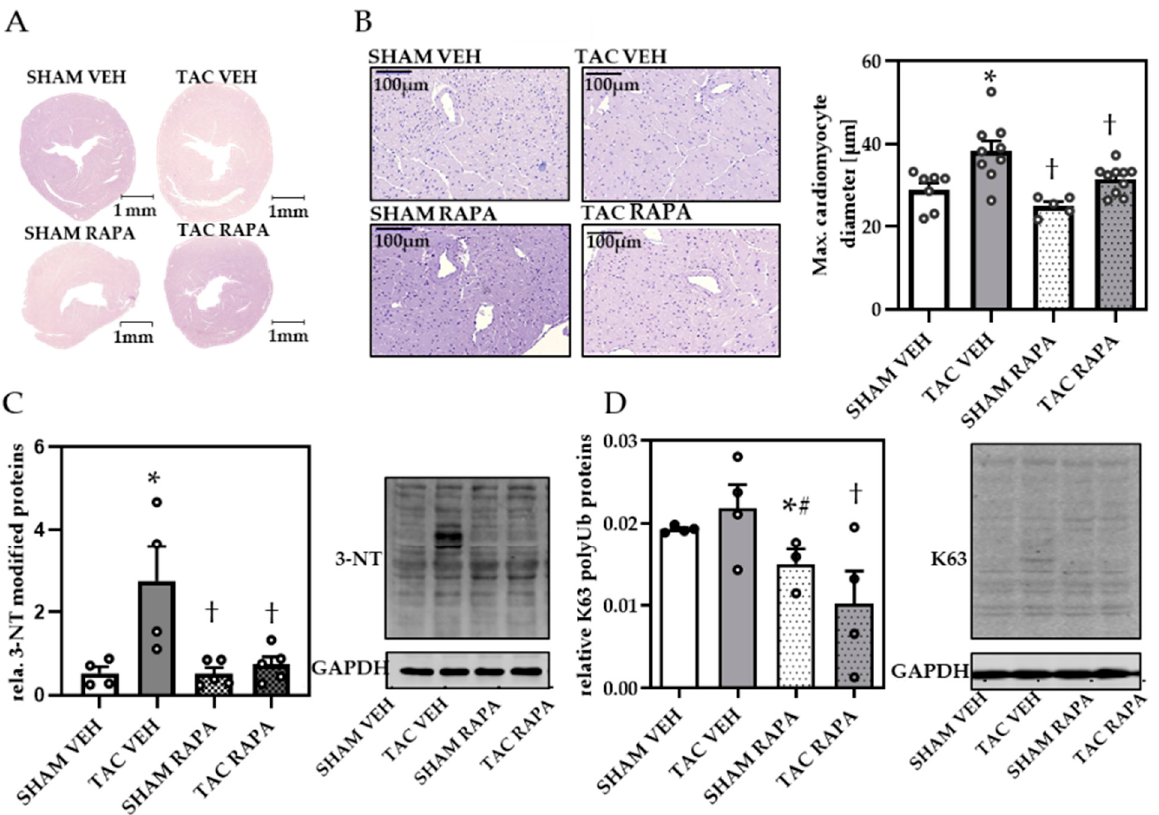
Figure 2. Rapamycin prevented TAC-induced cardiac remodeling in failing hearts. ( A ) H&E staining of cardiac cross-sections (magnification 1 × , scale bar = 1 mm). ( B ) Representative images of H&E stained cardiomyocytes (magnification 20 × , scale bar = 100 µ m) and quantification of max. cardiomyocyte diameter. ( C ) Relative 3-nitrotyrosine (3-NT) quantification and representative immunoblot. ( D ) Relative K63-polyubiquitinated protein (K63) quantification and representative immunoblot. Immunoblot data are normalized to GAPDH and all data are presented as Mean + SEM of biological replicates. Statistical analyses were performed by two-way-ANOVA followed Tukey’s posttest or unpaired t- test (indicated with #). Statistically significant differences are shown by p < 0.05, * vs. SHAM VEH, † vs. TAC VEH.